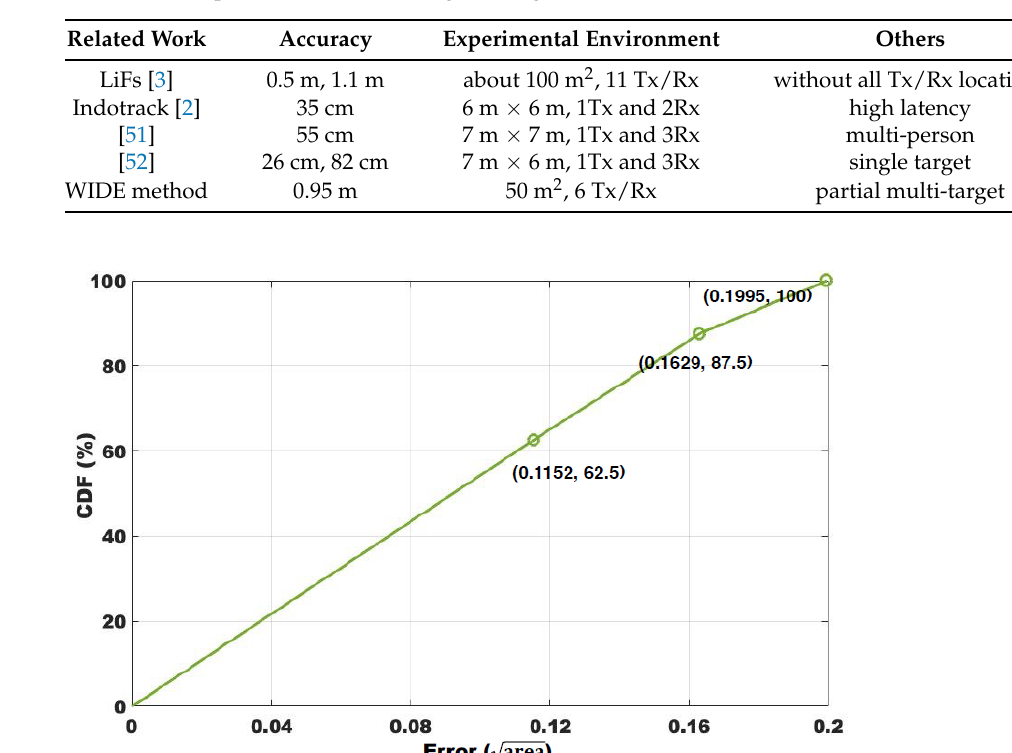
Table 1. A comparison of some existing tracking methods.